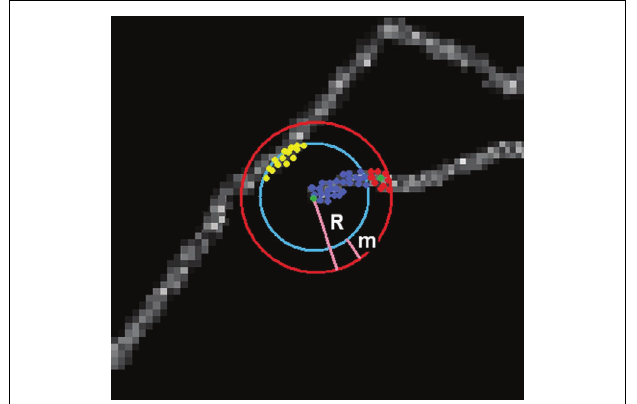
FIGURE 2 | Spanning graph around a seed point. Graph consists of vertices connected to seed V c (blue and red) and disconnected V d (yellow). Subset of V c are candidates (red) lying within a margin m from the surface of the sphere. Green point is the newly chosen seed point.